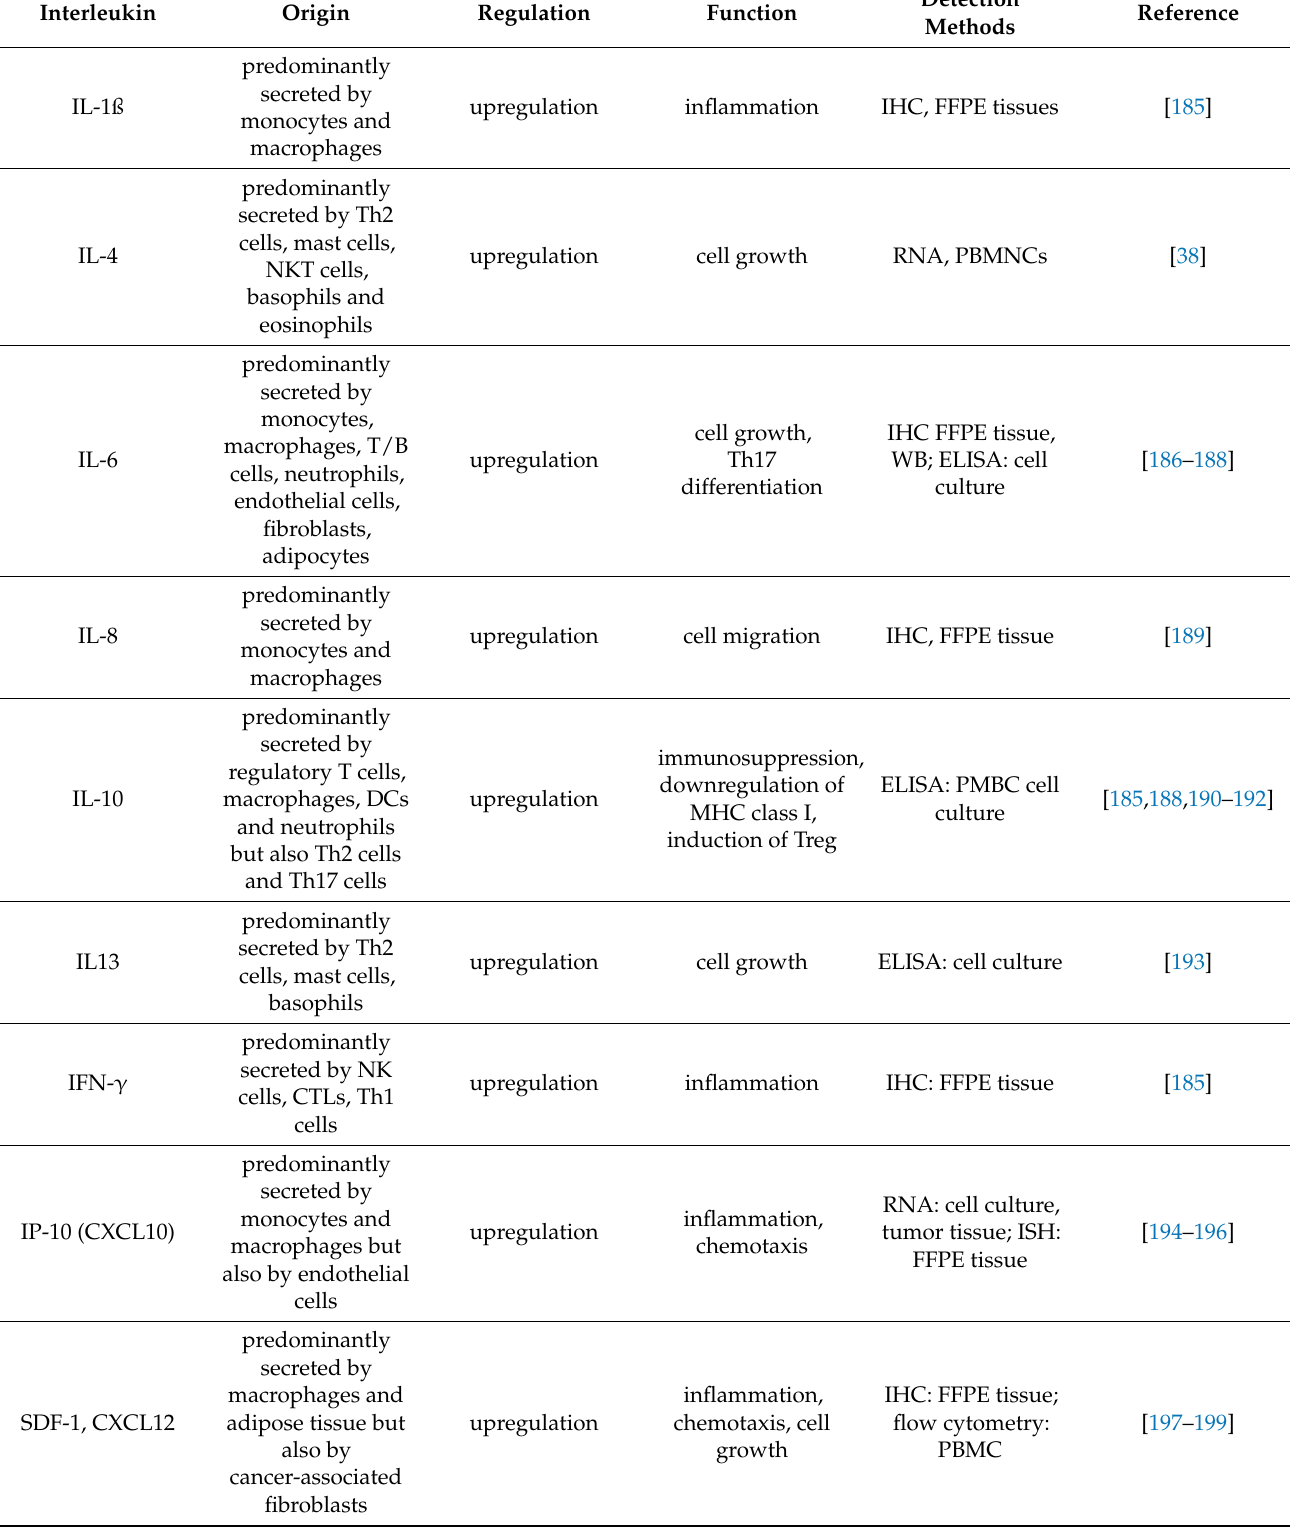
Table 5. Altered cytokine and chemokine expression pattern, their functional relevance and detection methods in EBV- associated